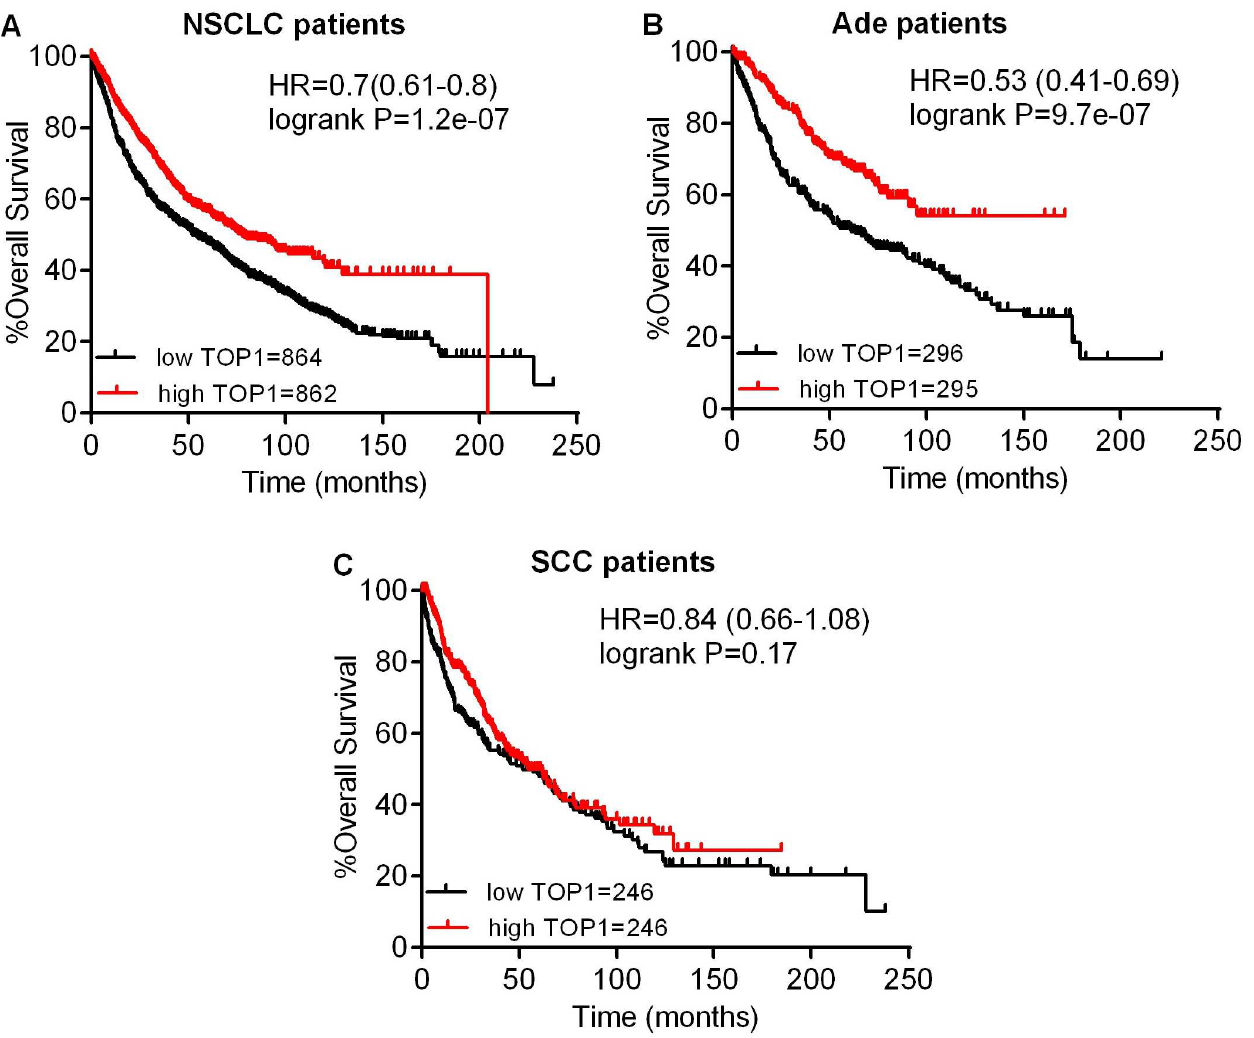
Fig 2. The prognostic value of TOP1 expression. (A) Survivalcurves were plotted for all NSCLC patients (n = 1726). (B) Survival curves were plotted for Ade patients (n = 591). (C) Survivalcurves were plotted for SCC patients (n = 492). Data was analyzedusing Kaplan-Meier Plotter. Patients with expressionabove the median are indicatedin red line, and patients with expressions belowthe medianin black line. HR means